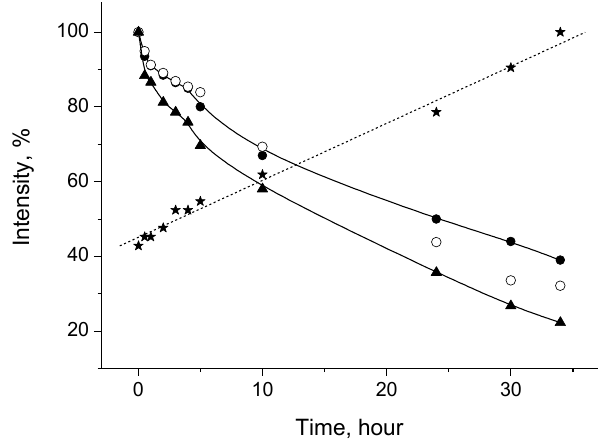
Figure 8. Dependences of EPR signal intensity as a function of time after switching off UV light for Ti 3+surf ( ▲ ), N • radical ( star ), Mo 5+ ( ○ ), and V 4+ (●)